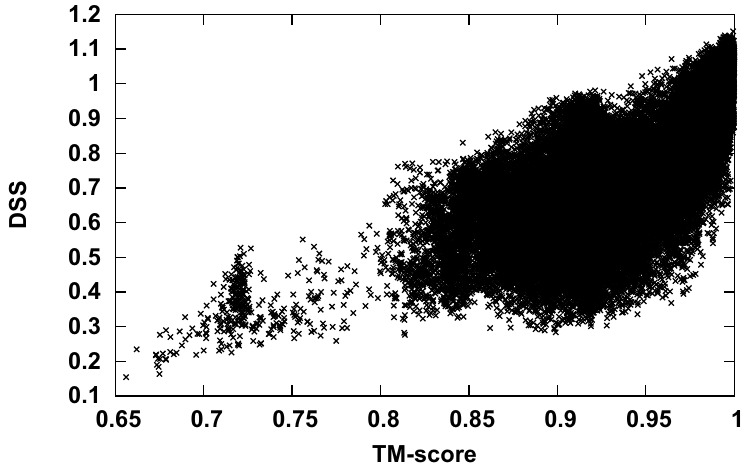
Fig 6. DSS as a function of the TM-score. The TM-scores (abscissa) versus the DSSs (ordinate) for all hemoglobin structures in dataset2 depicted using point plot.